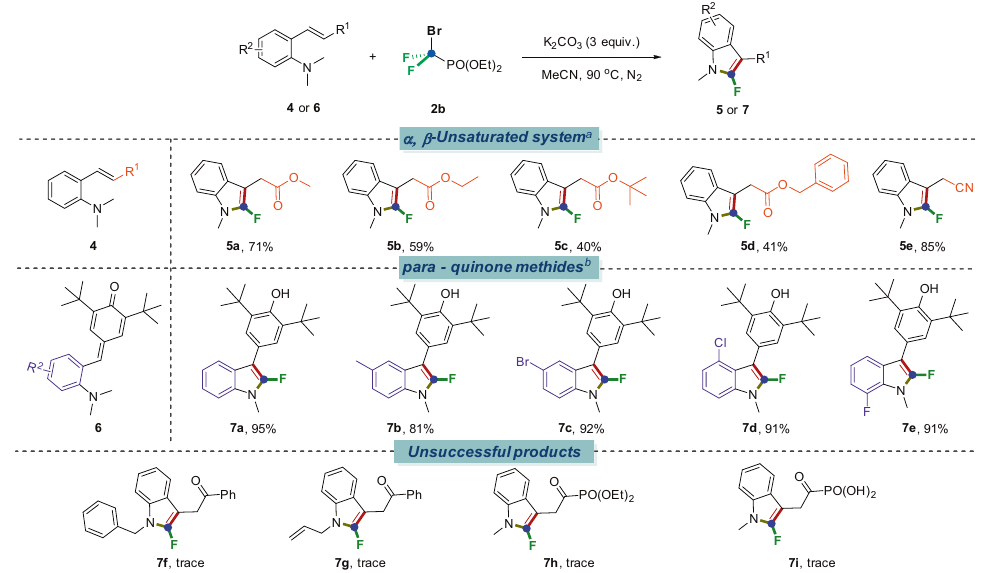
Fig. 3 Scope of other α , β -unsaturated system-containing anilines. Reaction conditions: a 4 (0.2 mmol), 2b (3 equiv., 0.6 mmol), K 2 CO 3 (3 equiv.), H 2 O (0.1 mL), CH 3 CN (2 mL) under 90 °C for 12 h, N 2 . b 6 (0.2 mmol), 2a (3 equiv., 0.6 mmol), K 3 PO 4 (3 equiv.), CH 3 CN (2 mL) under 90 °C for 12 h, N 2 .